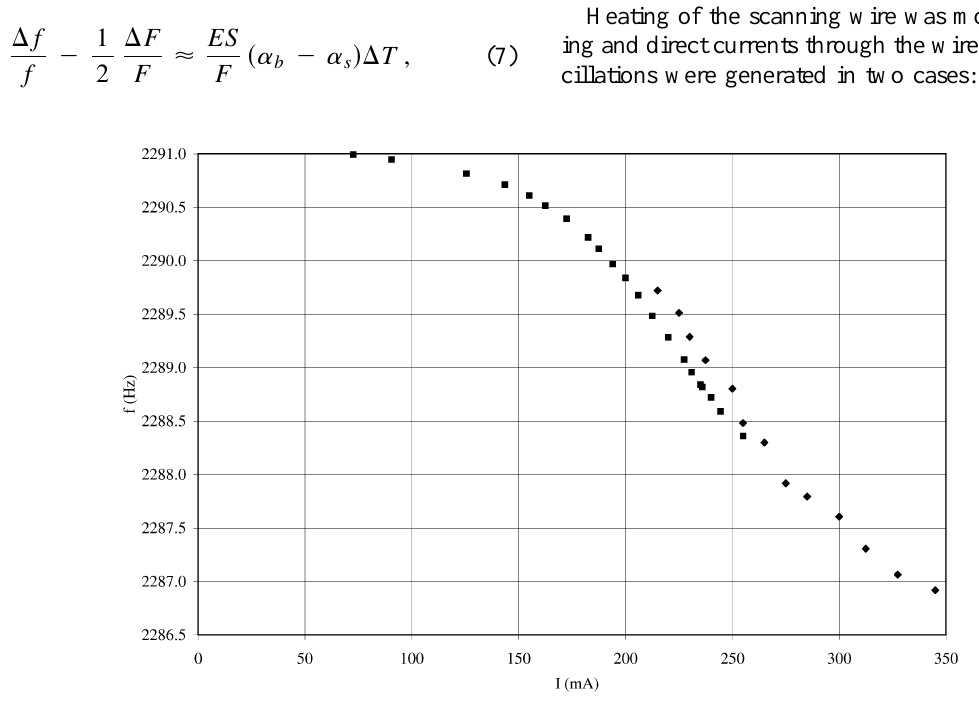
FIG. 5. Wire oscillation frequency dependence on the current through the wire in the model